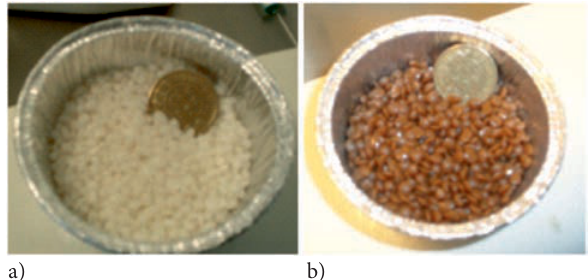
Fig. 1. WMA additives: a – Sasobit; b – Rediset